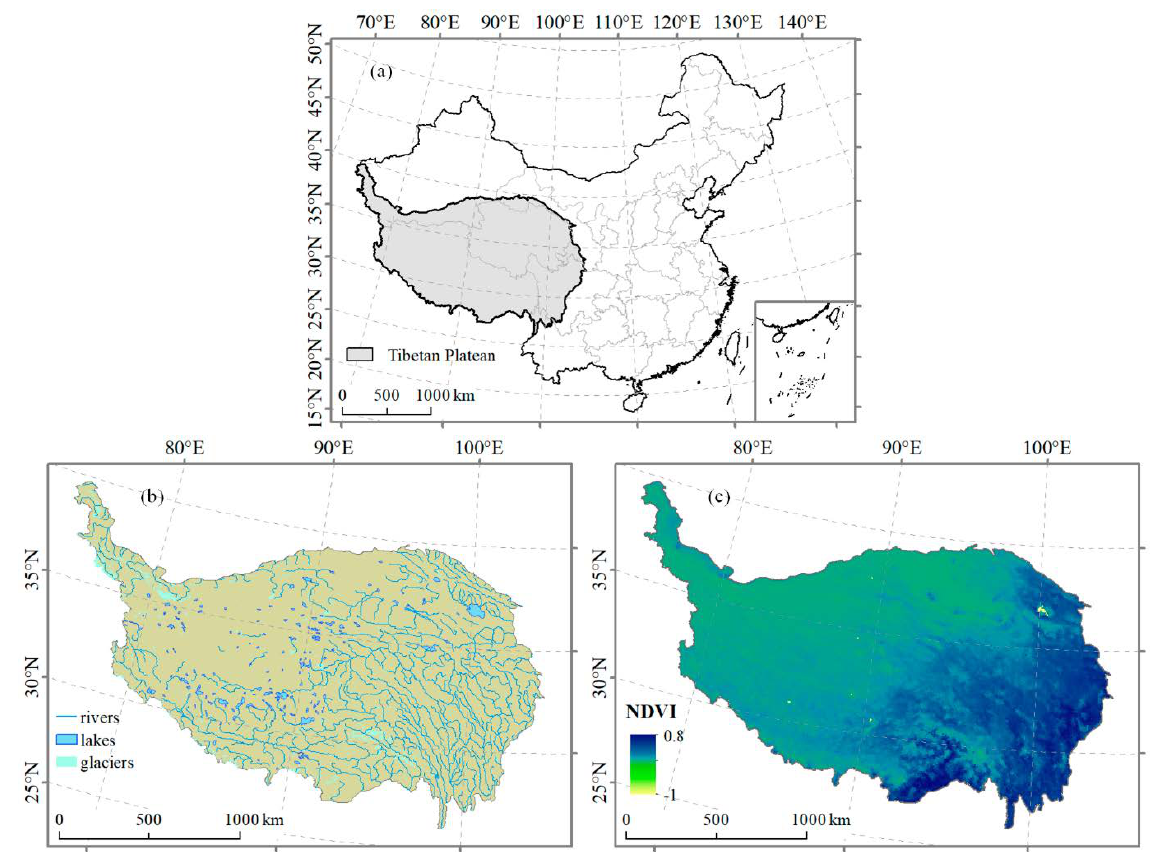
Figure 3. Map of the study area: ( a ) Location of the Tibetan Plateau in China, ( b ) distribution of rivers, lakes and glaciers in the Tibetan Plateau, ( c ) distribution of the normalized difference vegetation index (NDVI) in the Tibetan Plateau. The Tibetan Plateau stretches about 1000 km along the latitude and 2500 km along the longitude, with an average elevation exceeding 4000 m above sea level and an area of about 2.5 × 10 6 km 2 .